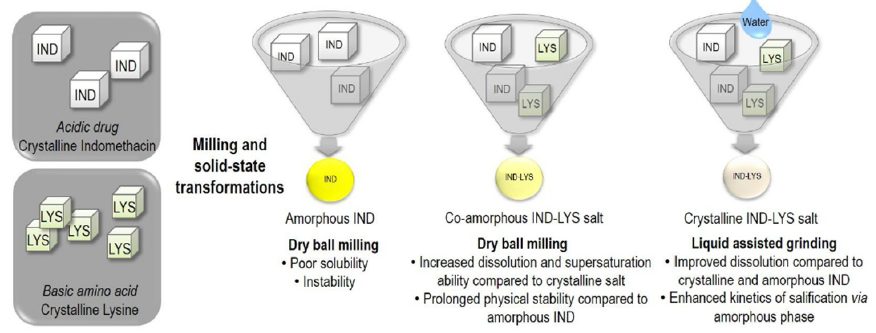
Figure 8. Different milling methods lead to amino acid salts with different properties [48].